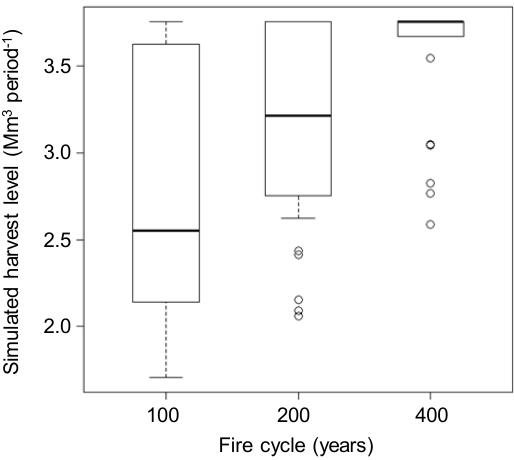
Figure 2. Box and whiskers plots representing the probability distributions of the simulated implementation of the optimal solution (3.8 Mm 3 period − 1 ) provided by the timber supply model (Equations (1)–(6)) under current (400 years) and probable interval for future fire regimes (100 and 200 years).